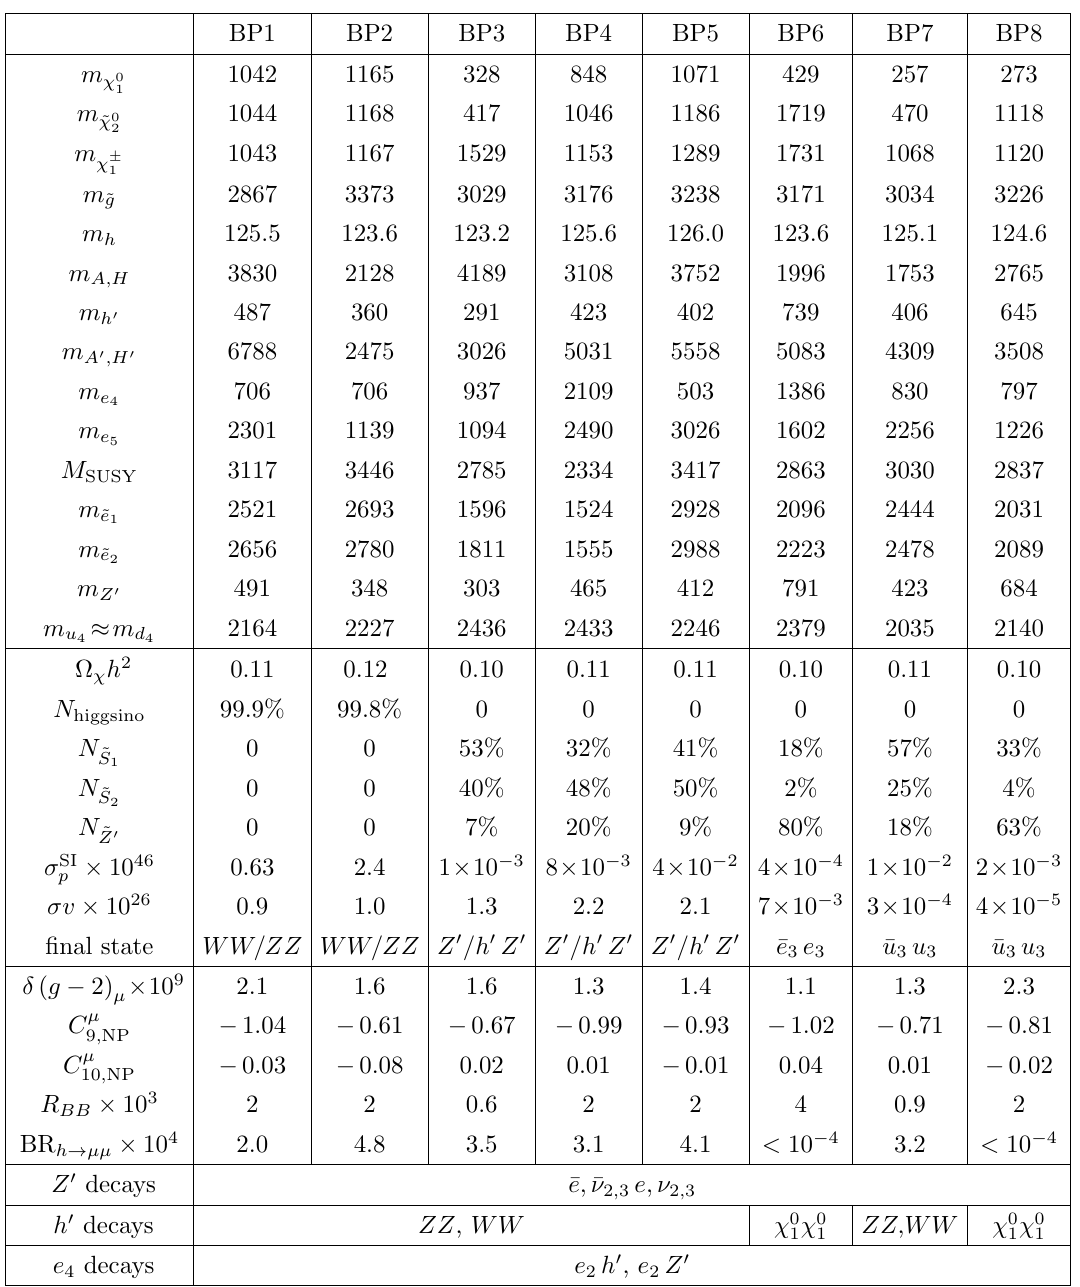
Table 2. Spectrum and various observables for our benchmark points. Masses are given in GeV, spin-independent cross section (cid:27) SI in cm 2 , and present-day annihilation cross section (cid:27)v in cm 3 p